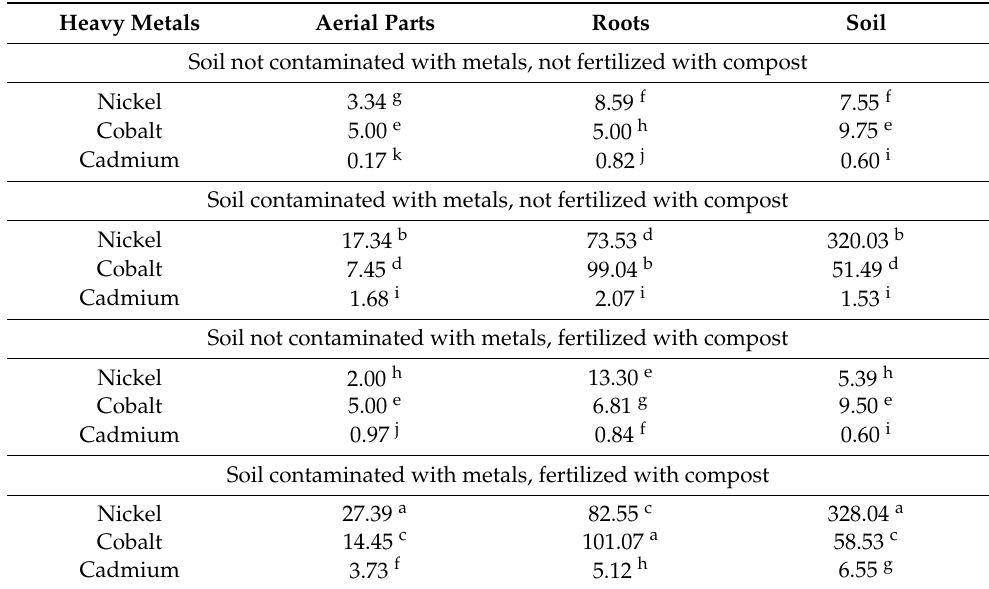
Figure 1. Aerial biomass and root yields of Festuca rubra in soil contaminated with heavy metals (in g d.m. kg − 1 soil) ( a ) and the heavy metals tolerance index (TI) of Festuca rubra ( b ). Heavy metal doses in 1 kg d.m. soils: C—control; Ni—400 mg; Co—80 mg; Cd—8 mg; Compost: C1—soil not fertilized with compost; C2—soil fertilized with compost; A—aerial plant parts; R—roots; homogeneous groups within above-ground parts and roots are marked with identical letters (a–e). Table 1. Content of nickel, cobalt and cadmium in the aerial parts and roots of Festuca rubra and in soil (in mg kg − 1 plant/soil d.m.).